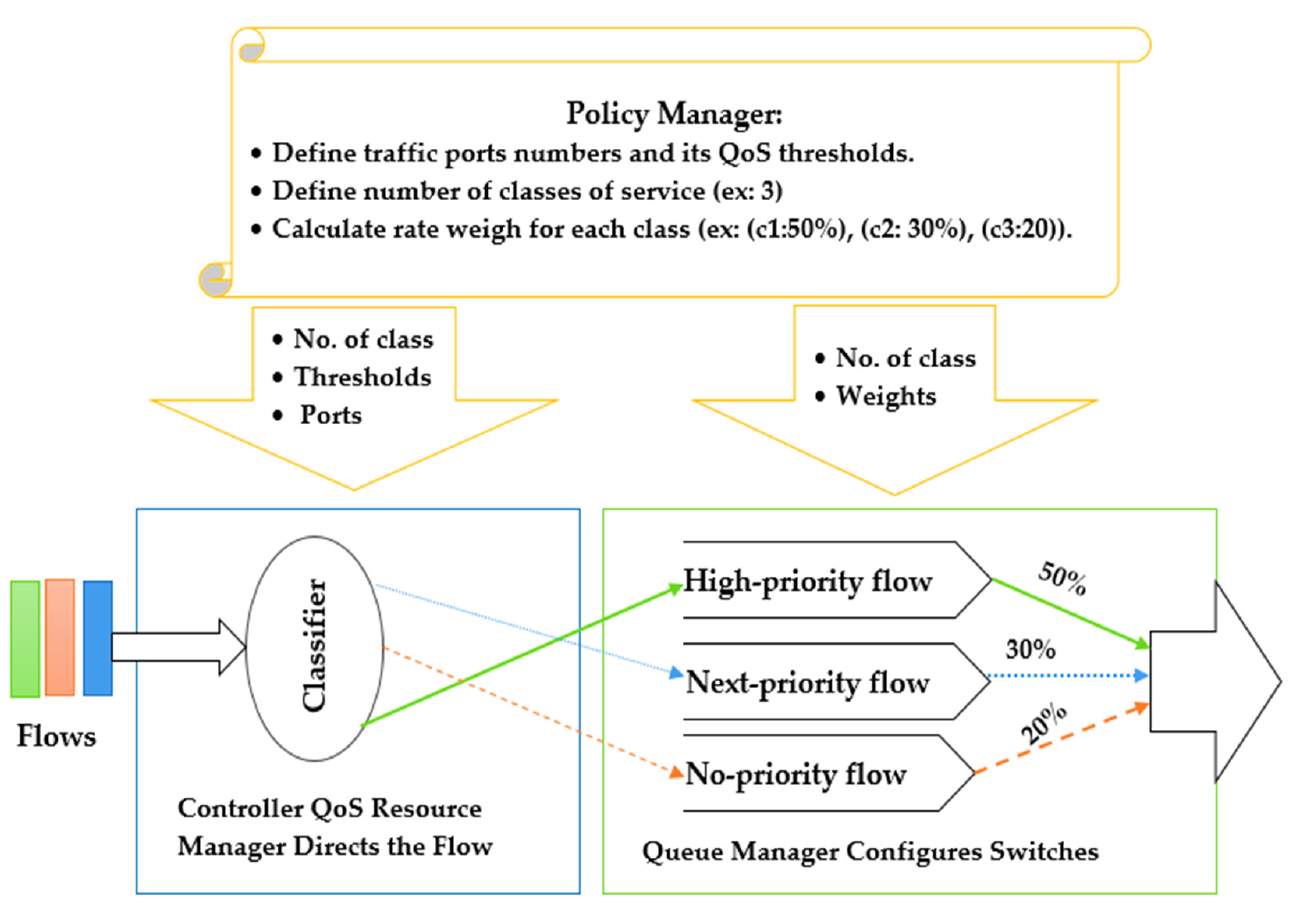
Figure 4. Illustrative example of the queues allocation process.